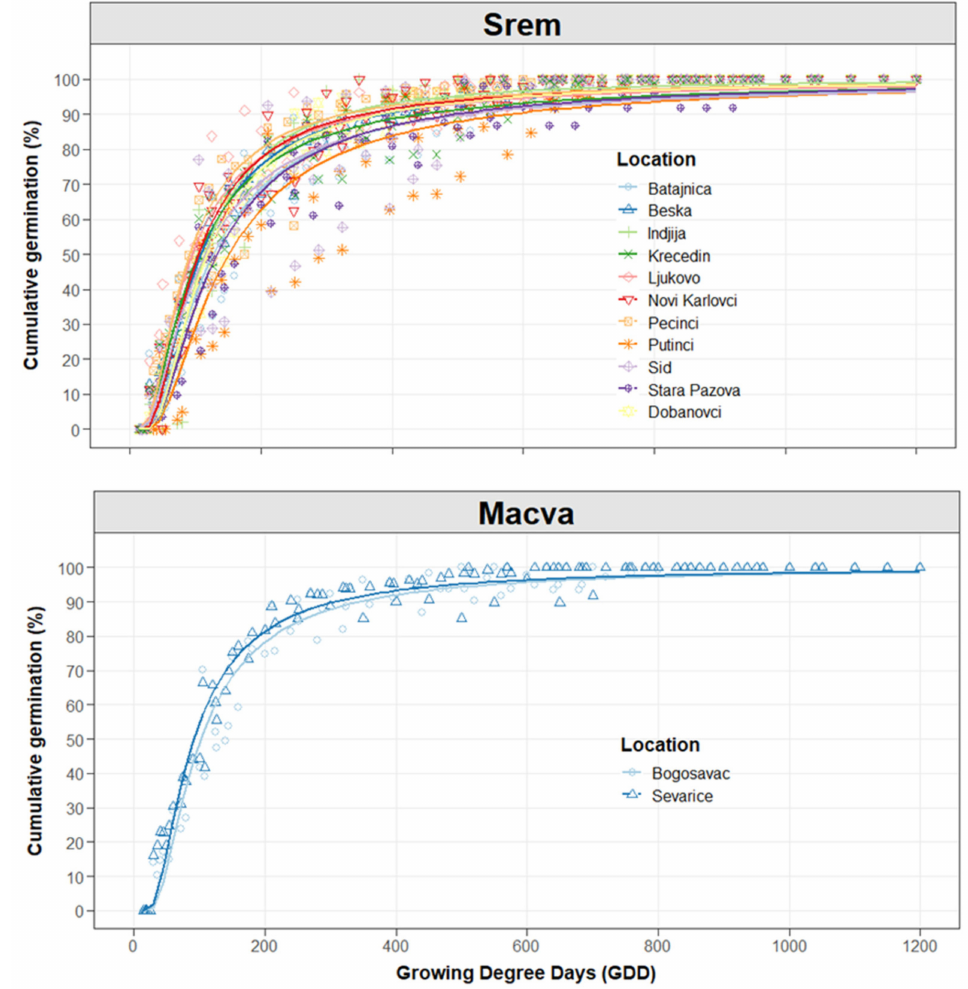
Figure 4. Cumulative germination (%) by locations grouped by regions during growing degree days